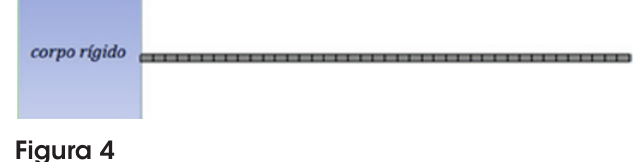
Figura 4 Malha de elementos finitos para o domínio da